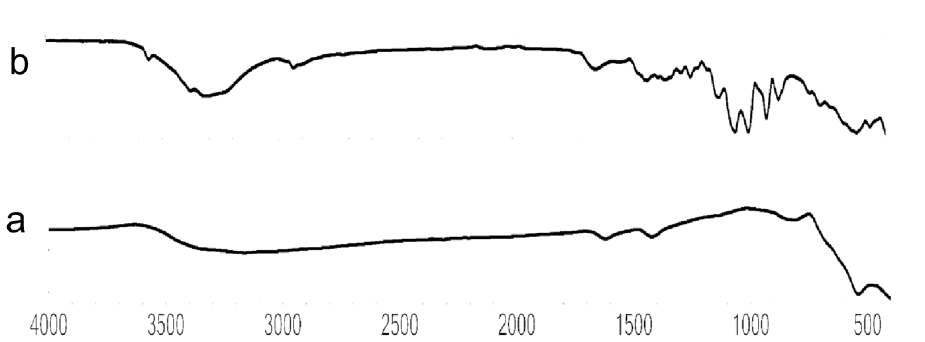
Figure 2. FTIR analysis of ( a ) SPIONs; ( b ) Latex coated